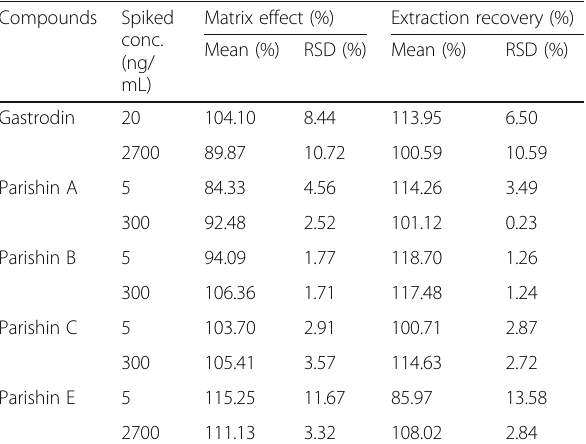
Table 3 Matrix effects ( n = 5) and extraction recovery ( n = 3) results for analysis of the five analytes and I.S. in rat plasma Compounds Spiked